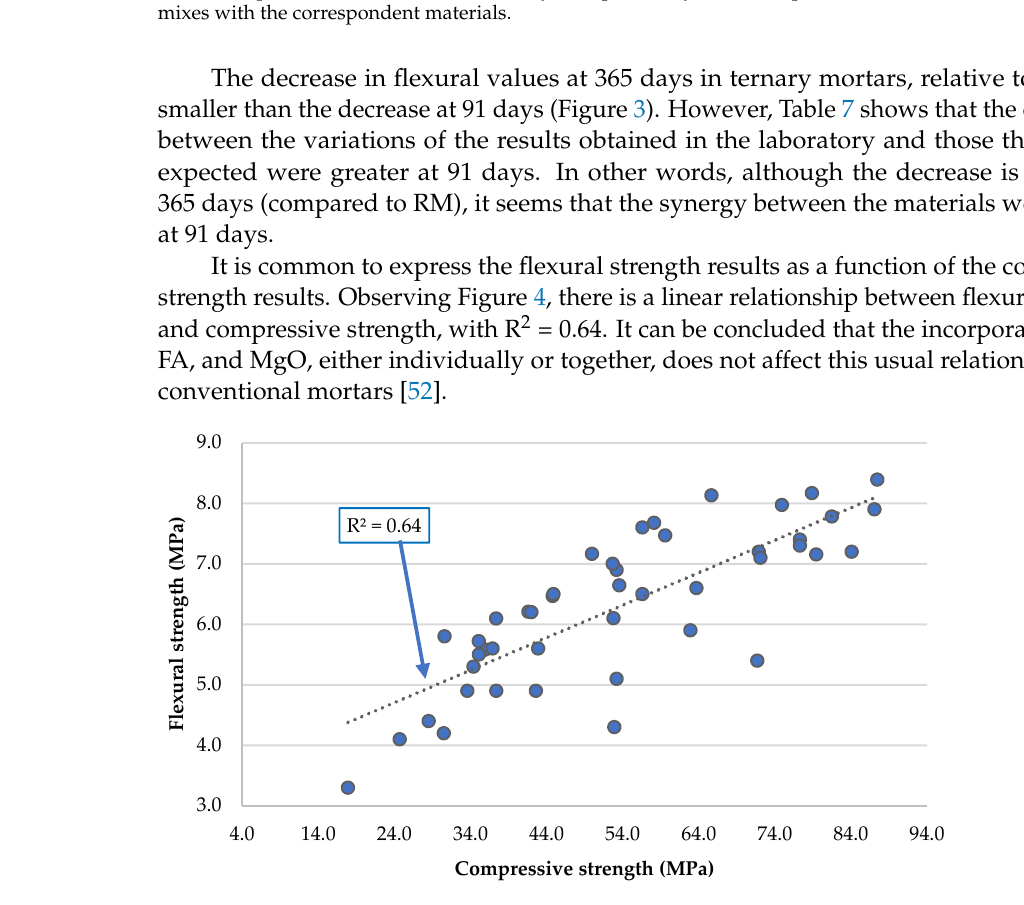
Figure 4. Relationship between flexural strength and the compressive strength (at the same age).